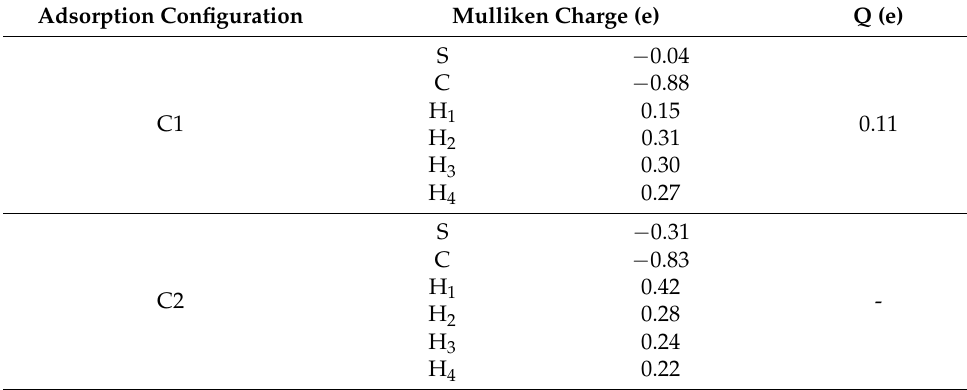
Figure 10. ( a ) The PDOS of the S atom in a free CH 3 SH molecule; ( b ) the PDOS of pure α -Fe 2 O 3 (001) surface Fe atom and S atom of CH 3 SH after adsorption; ( c ) the PDOS of the Fe atom and the S atom of CH 3 SH atom on the surface of the vacancy α -Fe 2 O 3 (001) after adsorption; ( d , e ) the charge difference density of CH 3 SH molecules adsorbed on the pure 2 O 3 (001) surface; and ( f , g ) the charge difference density of CH 3 SH molecules adsorbed on the vacancy α -Fe 2 O 3 (001) surface. Table 5. The Mulliken charge population analysis of CH 3 SH adsorbed on the α -Fe 2 O 3 (001)